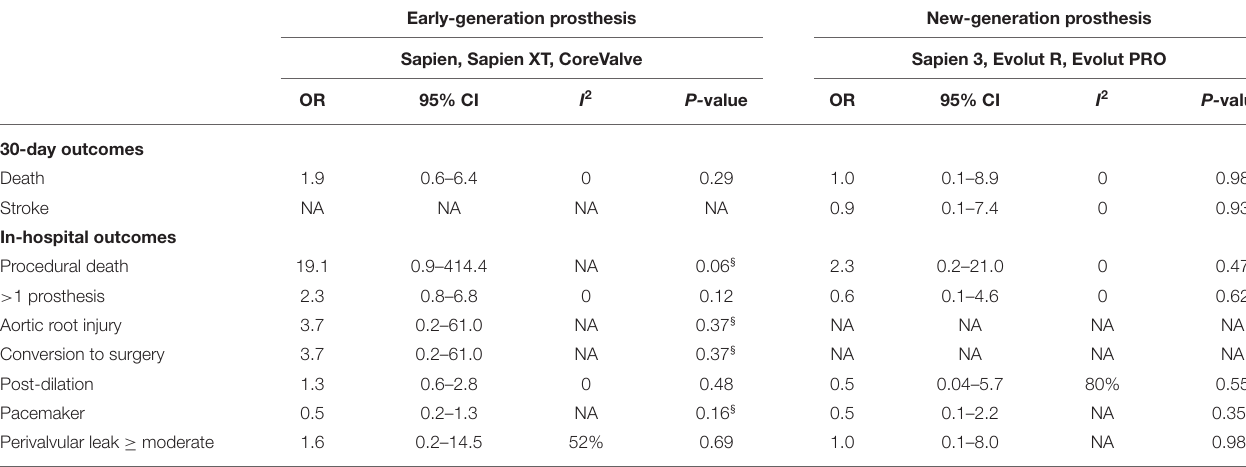
TABLE 7 | Subgroup analyses of different generations of prosthesis*.